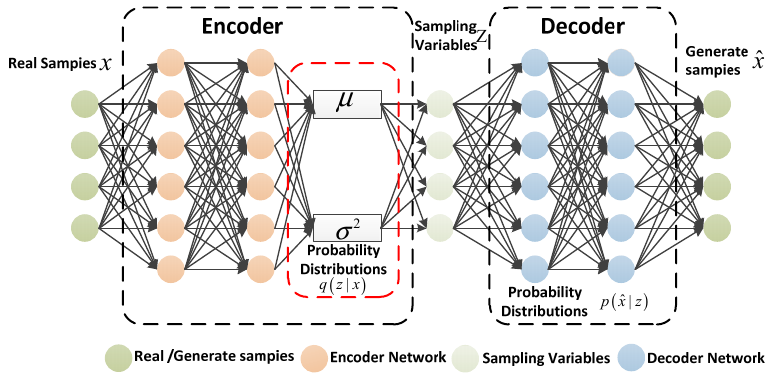
Figure 1. The overall framework of the VAE model.